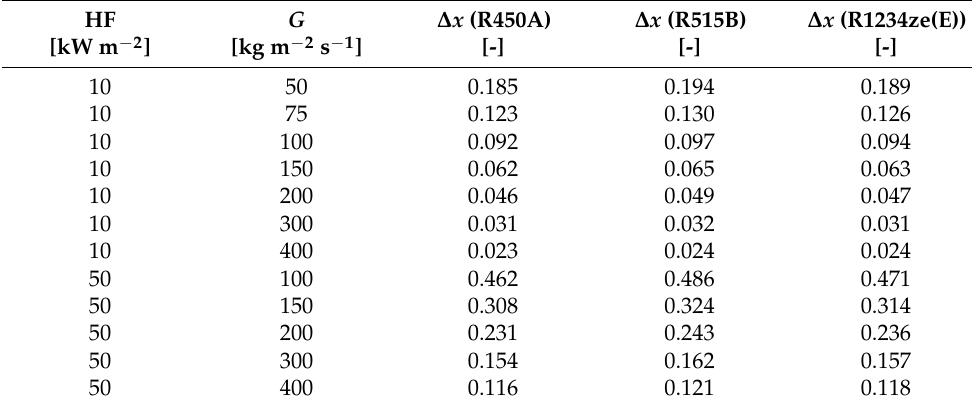
Table 2. Vapor quality differences for the data reported in Figure 3 at t sat = 30 ◦